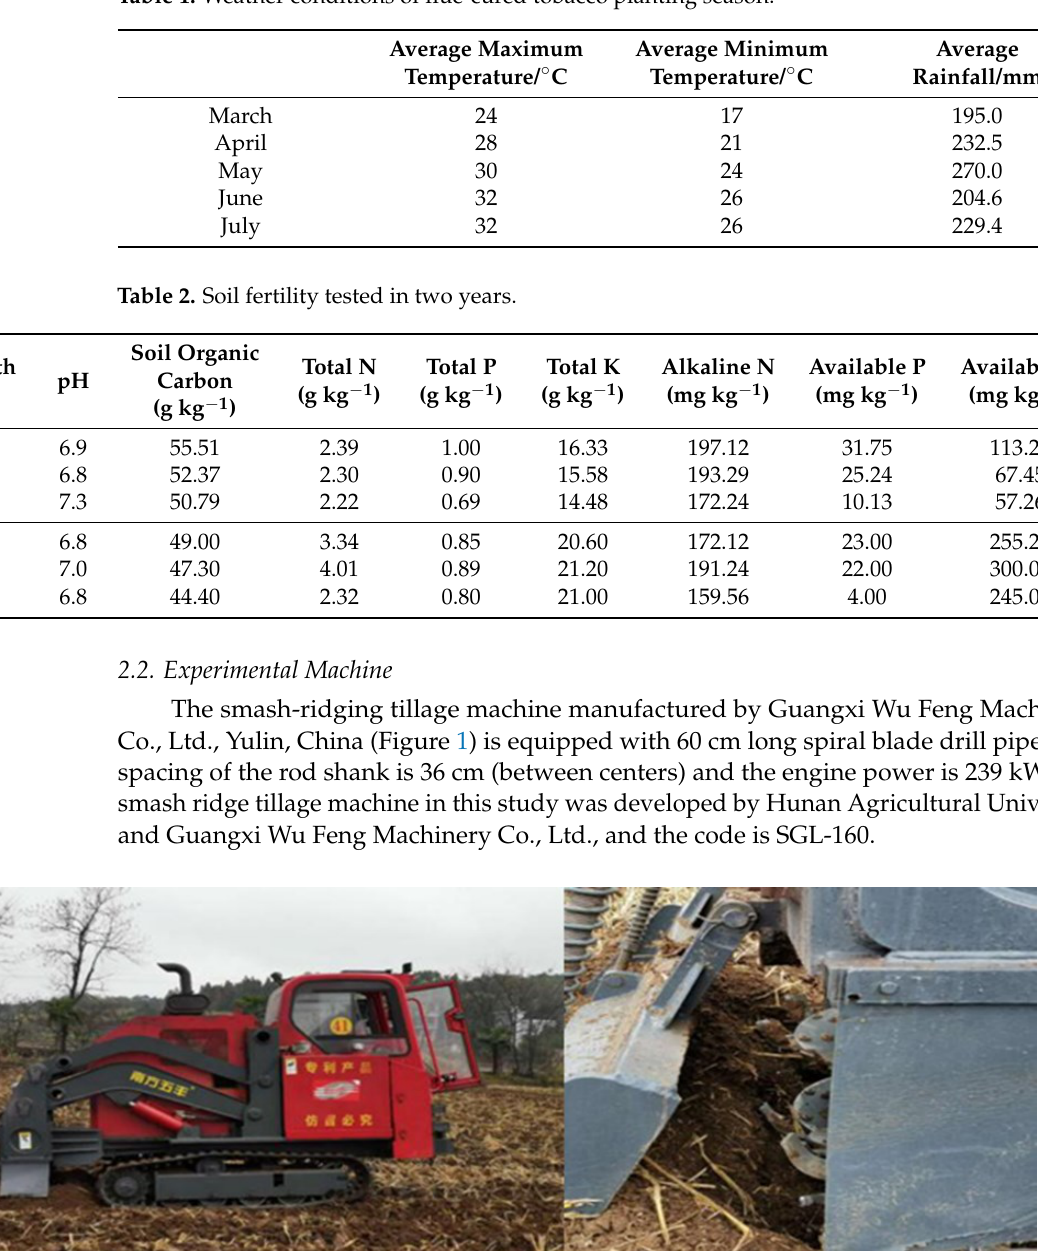
Table 1. Weather conditions of flue-cured tobacco planting season.